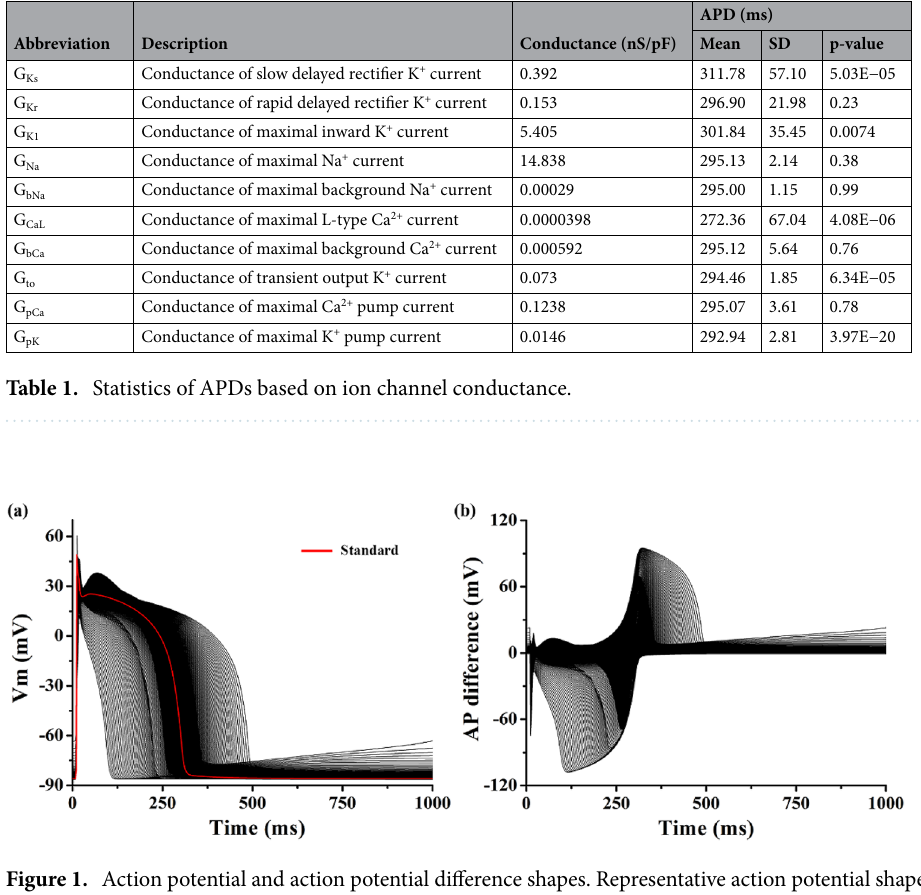
Figure 1. Action potential and action potential difference shapes. Representative action potential shapes ( a ), and representative action potential difference shapes ( b ); action potential difference between standard membrane potential (red line) and changed membrane potential due to change in specific ion